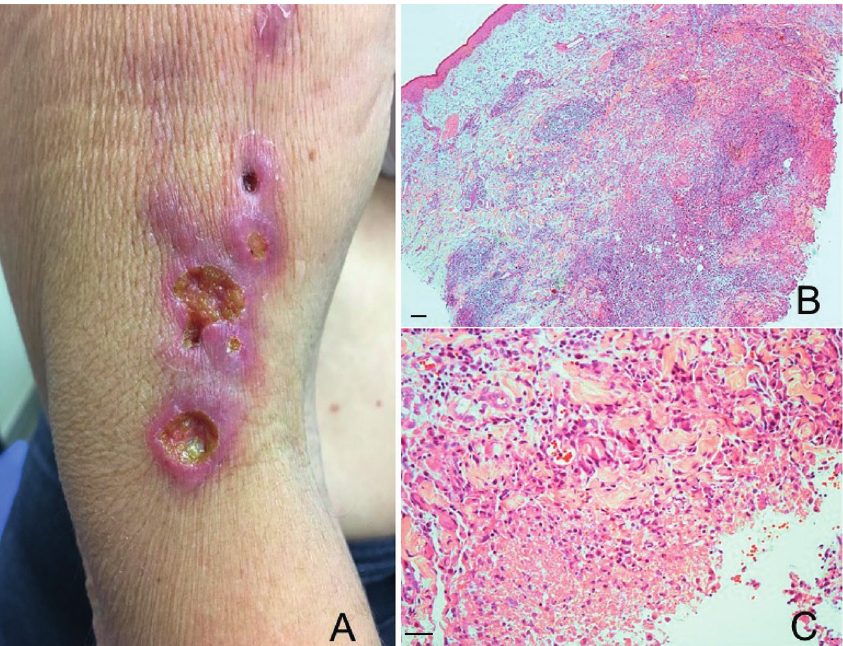
Figure 1: (a) Ulcerated lesions with borders showing erythema and infiltration. (b) Histological section showing the dense inflammatory infiltrate with the presence of granulomas; magnification 100x. (c) Focal necrosis and neutrophil exudation; magnification 200 × . His- tological sections were stained with hematoxylin and eosin. Bars � 5 μ m.